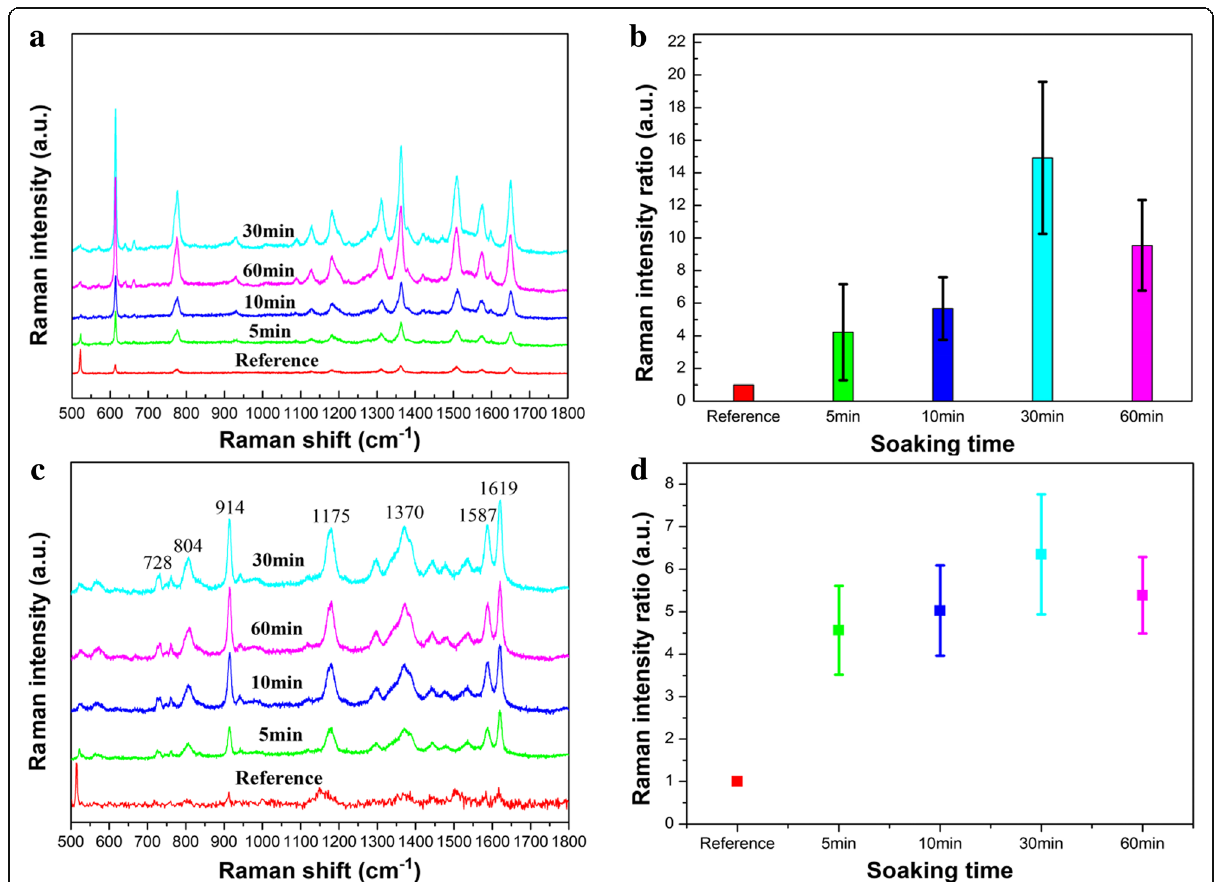
Fig. 3 a Raman spectra of 10 − 7 M Rh6G on the GNR vertical array substrate with different soaking times. b Raman intensity ratio of the peak at 1650 cm − 1 on the GNR vertical array substrate with different soaking times. c Raman spectra of 10 − 6 M CV on the GNR vertical array substrate with different soaking times. d Raman intensity ratio of the peak at 1619 cm − 1 on the GNR vertical array substrate with different soaking